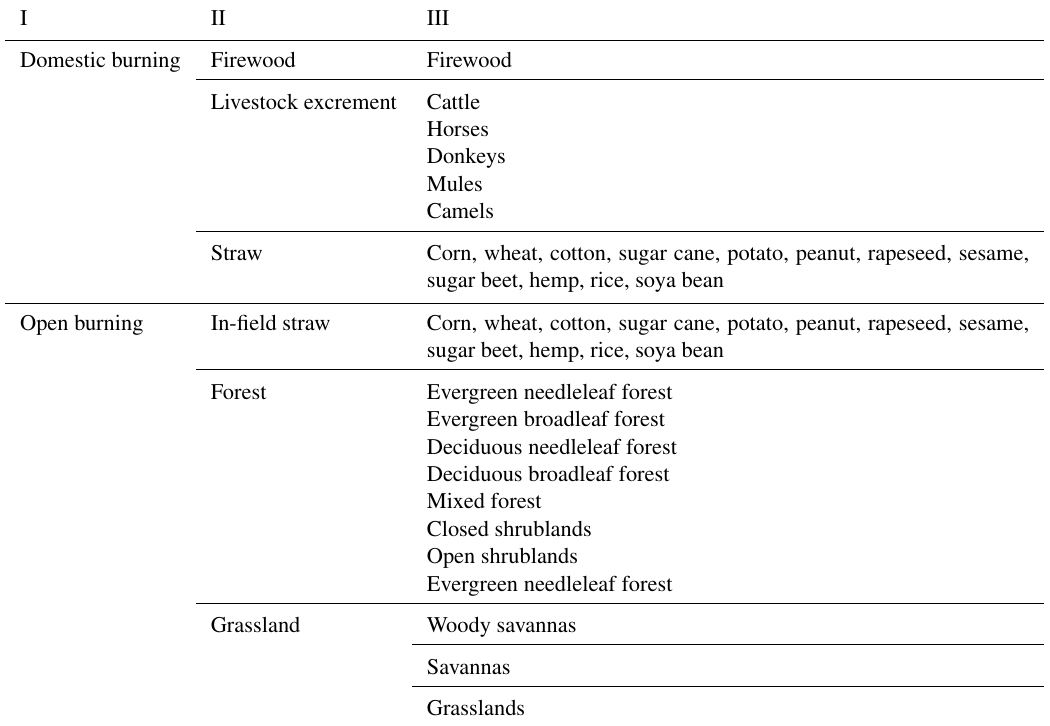
Table 1. Classification of biomass burning emission sources.